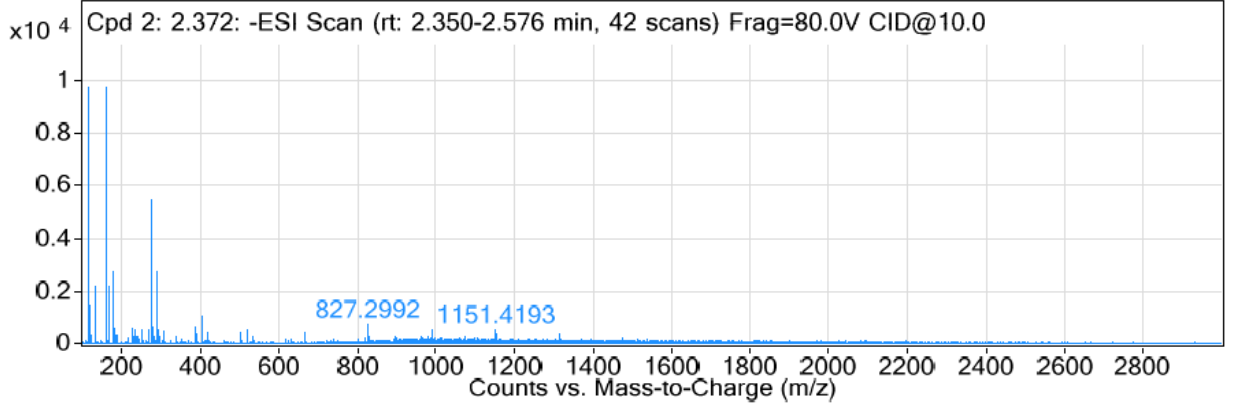
Figure 4. MS spectrum related to the chromatogram in Figure 2, peak at RT = 2.372. The most abundant bioactive compounds from the hydrolysate, identified in the MS spectra with a negative ionization are listed in Table 5. Table 5. Possible bioactive compounds identified in the hydrolyzed sample in MS spectra with negative ionization.